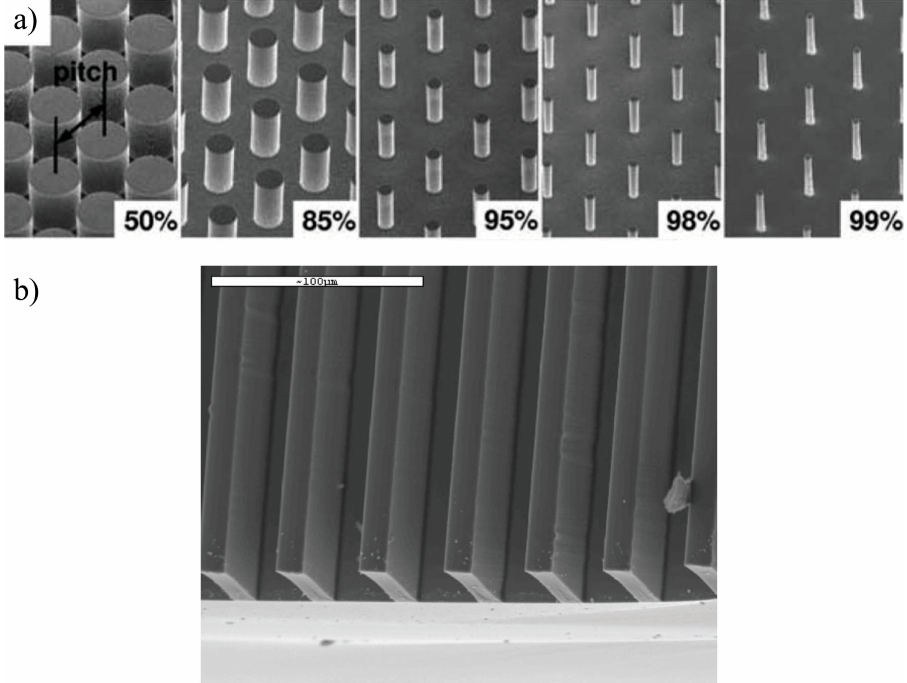
Figure 11. ( a ) Scanning electron microscope (SEM) images of post patterns with 50 µ m pitch for the displayed inset gas fractions; from Lee et al. [6]. ( b ) Image of microfabricated surface with microridges, width of cavities and ridges are respectively 30 and 10 µ m, depth of rib is 15 µ m; from Maynes et al.